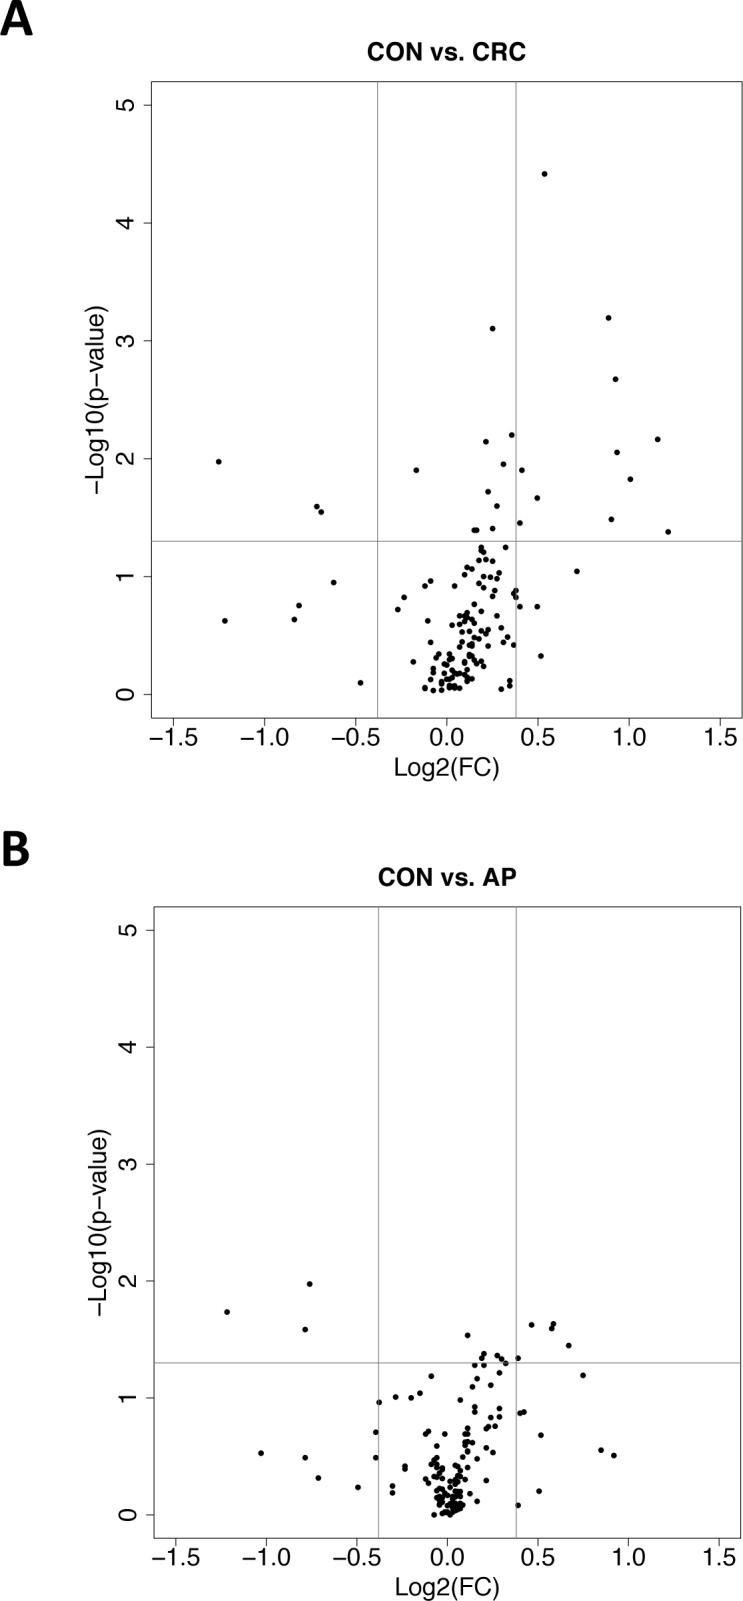
Differential gene expression analysis of 140 genes.The volcano plots summarize the gene expression fold-changes (FC) (x-axis) and the p-values (y-axis) for the comparisons: A, CRC versus control or, B, AP versus control. P-value cutoff was fixed at 0.05 (horizontal line) and fold-change threshold at ±0.38 (equivalent to ± 1.3 in linear scale, vertical line). A FC equal to 1 means that the gene is expressed in the group of interest, on average, twice as much than in the control group.